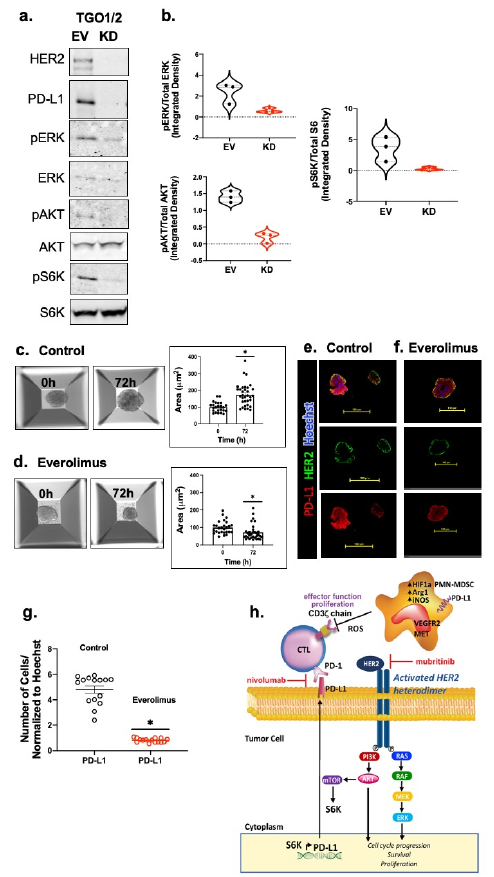
Figure 8. Inhibition of HER2 regulates PD-L1 expression by suppressing HER2/AKT/MTOR signal- ing in gastric cancer-derived organoids. The expression of the HER2/AKT/MTOR signaling pathway components were determined by ( a ) Western blot analysis. ( b ) Violin plots representing densito- metric values of protein bands measured from 8a. Brightfield images and the calculated organoid